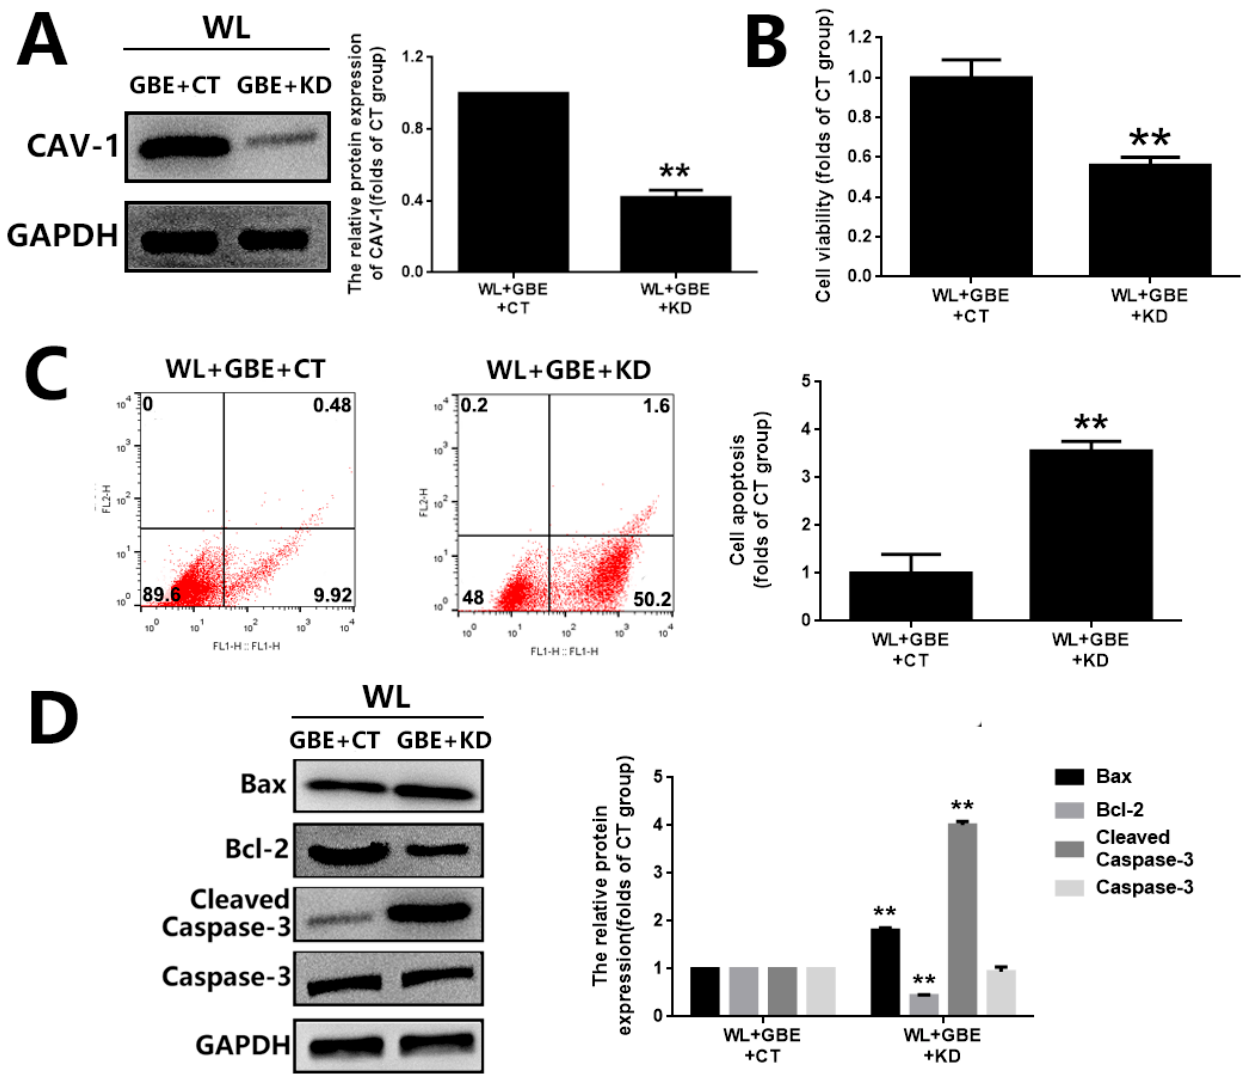
Figure 8. CAV-1 silencing attenuated the cytoprotective effect of GBE on photoreceptor degeneration in 661W cells exposed to WL illumination. The 661W cells with or without CAV-1 silencing were pre-treated with GBE (100 mg/L, 24 h) and then exposed to WL (4000 lux) for 2 h. ( A ) The silencing of CAV-1 was verified by Western blot analysis. ( B ) Cell viability was assessed by MTT assay. ( C ) Cell apoptosis was analyzed by Annexin V-FITC and PI double-staining assay. Representative images of cell apoptotic profiles are shown on the left. Percentages of apoptotic cells are summarized in the right panel. ( D ) The expressions of apoptosis-related proteins (Bax, Bcl-2 and Caspase-3) were evaluated by Western blot analysis (left panel). The densitometry analysis of each protein is shown in the right panel. ** p < 0.01 vs. WL + GBE + CT. WL: white light, CT: 661W cells without CAV-1 silencing, KD: 661W cells with CAV-1 silencing.